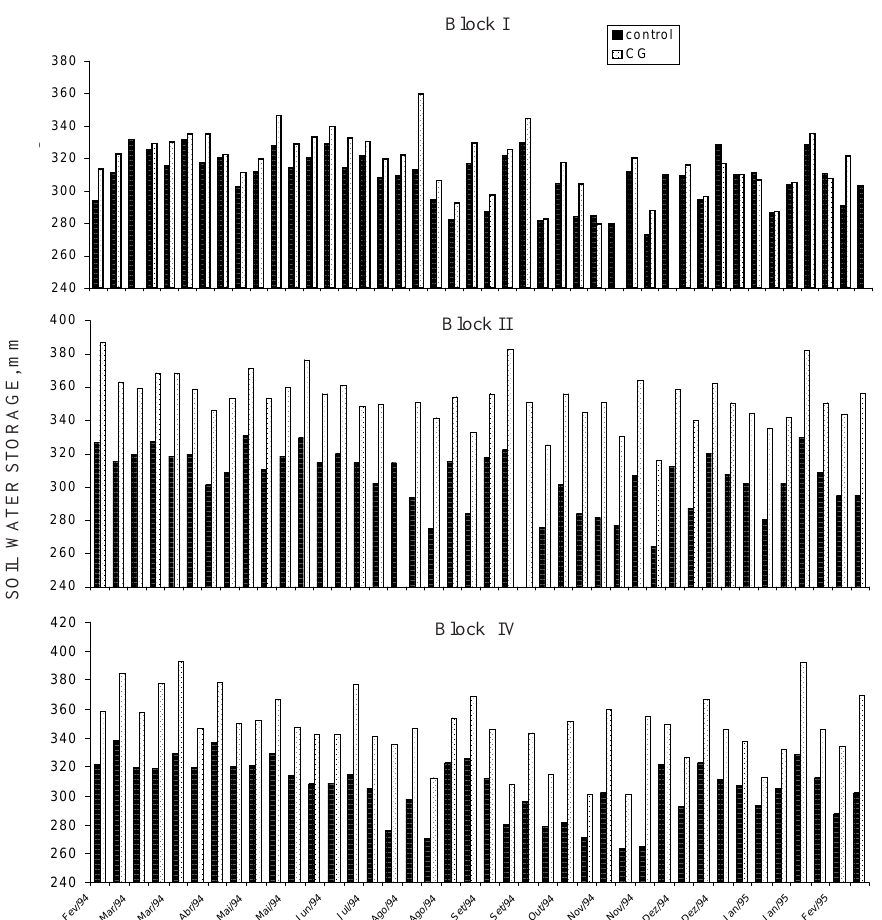
Figure 1. Soil water storage in the forest control and centre of gaps (CG), in blocks I, II, and Table 4. Analysis of variance for soil water storage, in three climatic periods